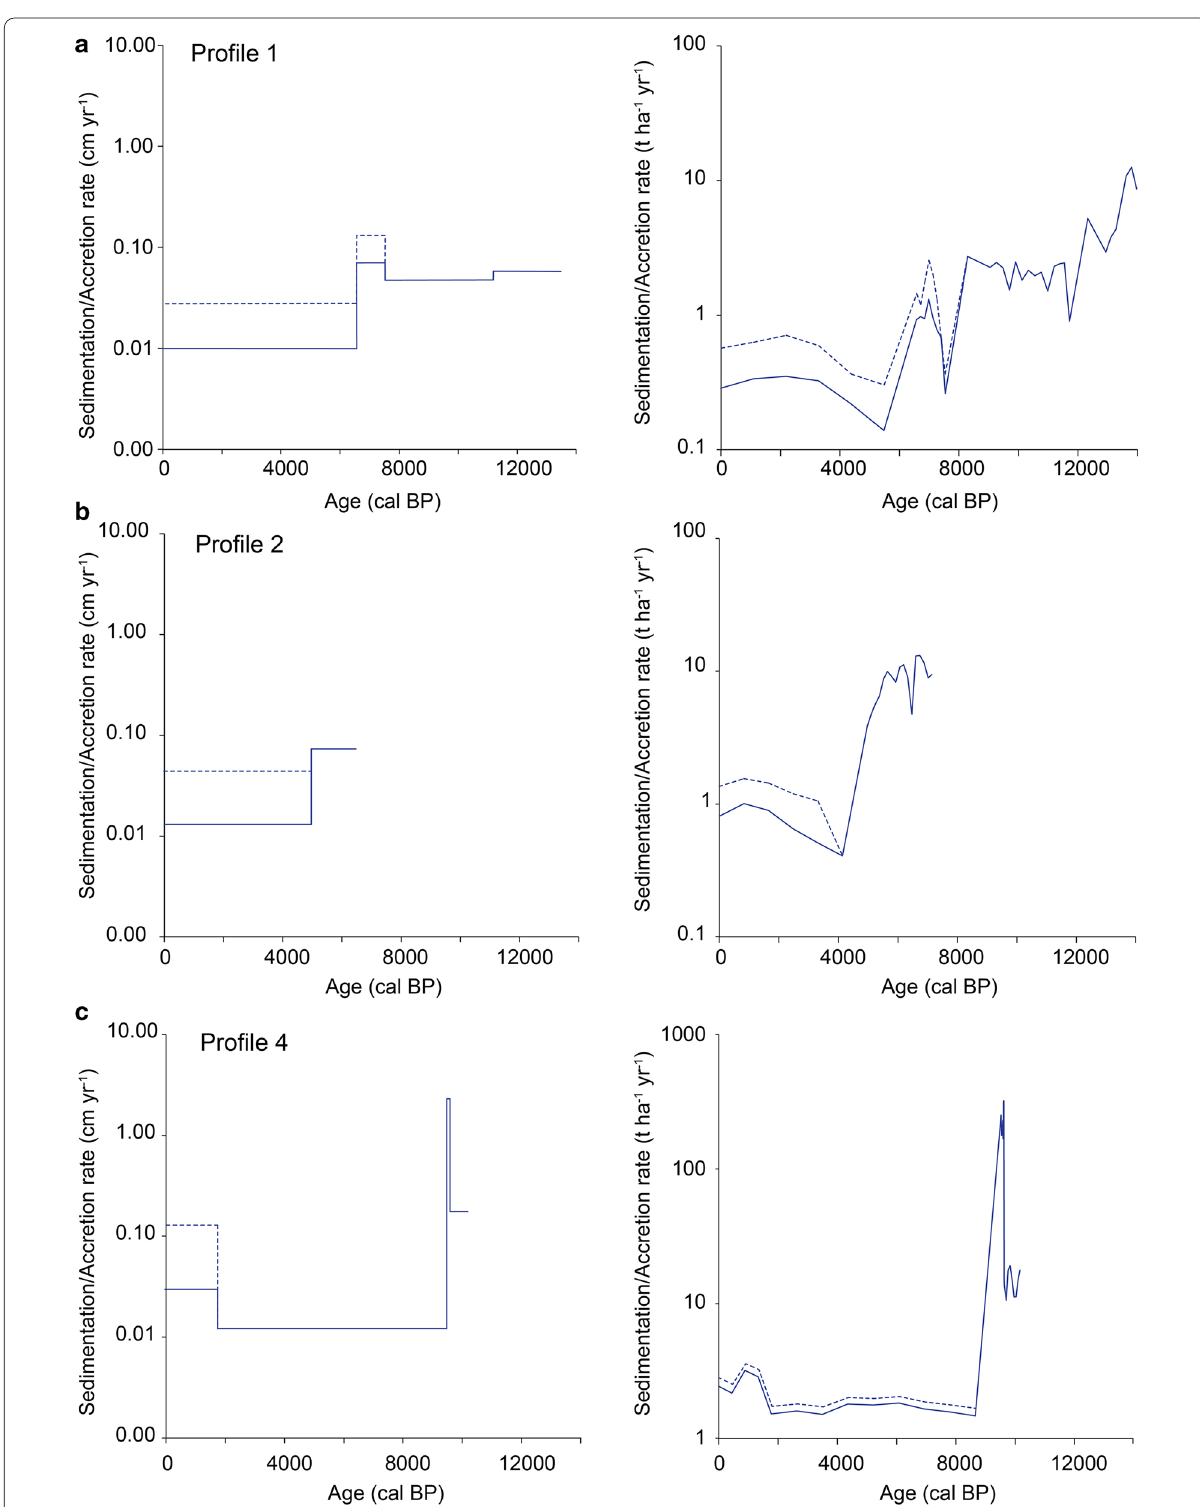
Fig. 9 Sedimentation or accretion rates as a function of time at the sites a 1, b 2 and c 4. The rates are plotted as cm year − 1 (including, thus, a length unit) and as t ha − 1 year − 1 (including a weight unit; the depth- and thus time-dependent bulk density of the deposited/accreted material was taken into account). The dotted lines indicate the sedimentation or accretion rates if no degradation of mires had taken